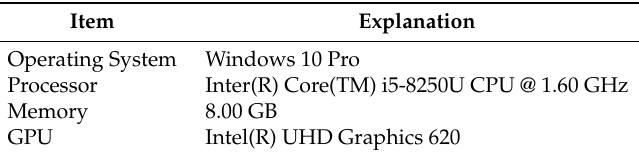
Table 3. Experimental